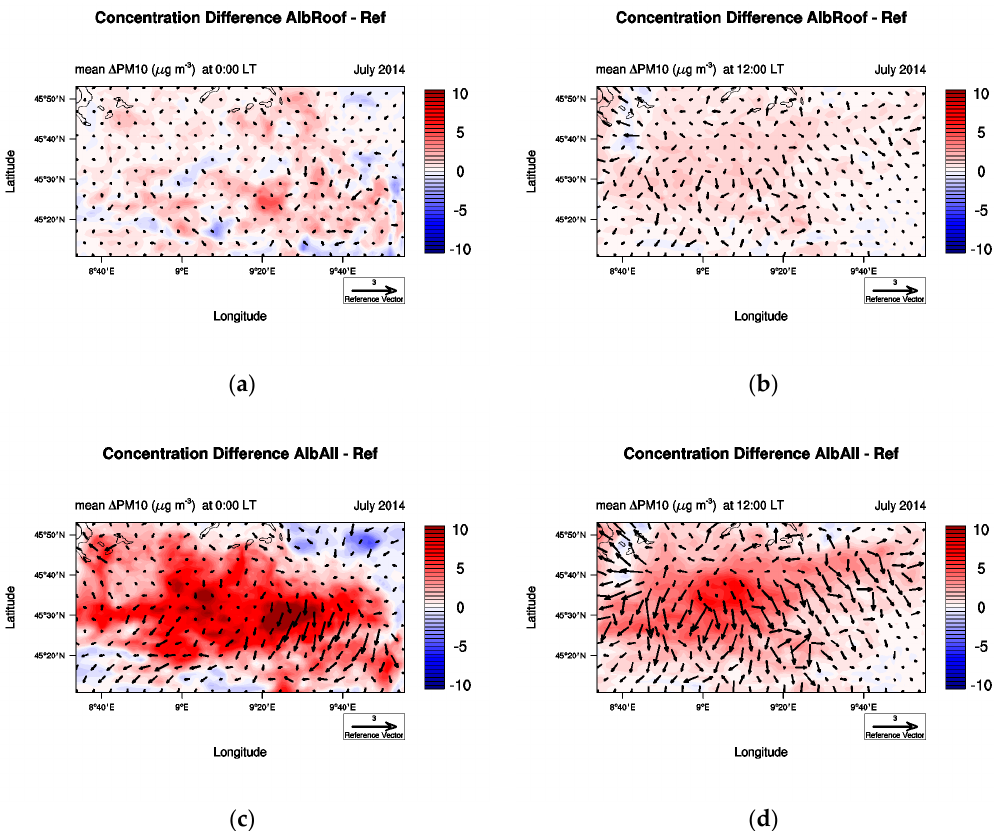
Figure 9. Difference of average PM10 concentration between tests using highly reflective materials and the reference case at 00:00 LT (left) and at 12:00 LT (right). From top to bottom: ( a , b ) difference between AlbRoof and Ref, ( c , d ) difference between AlbAll and Ref.